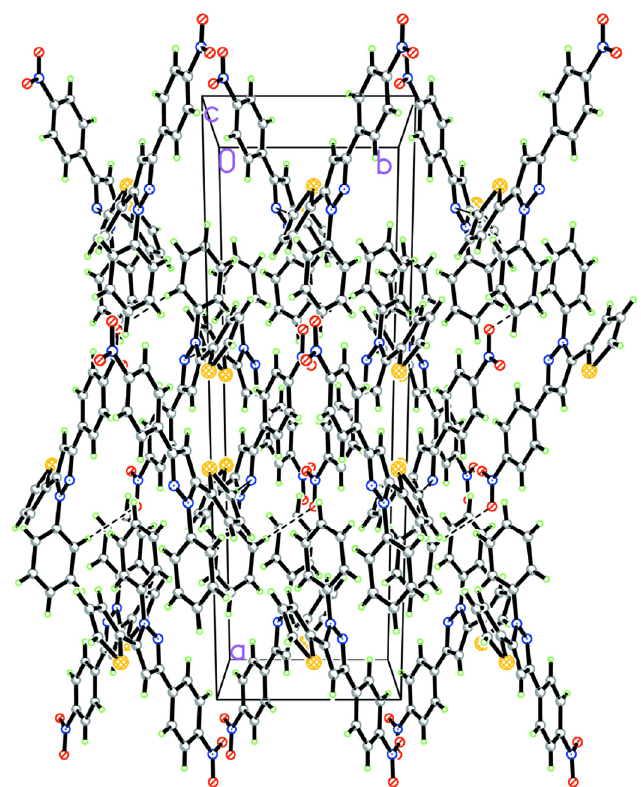
Figure 2. A view of the crystal packing down the c axis for the title